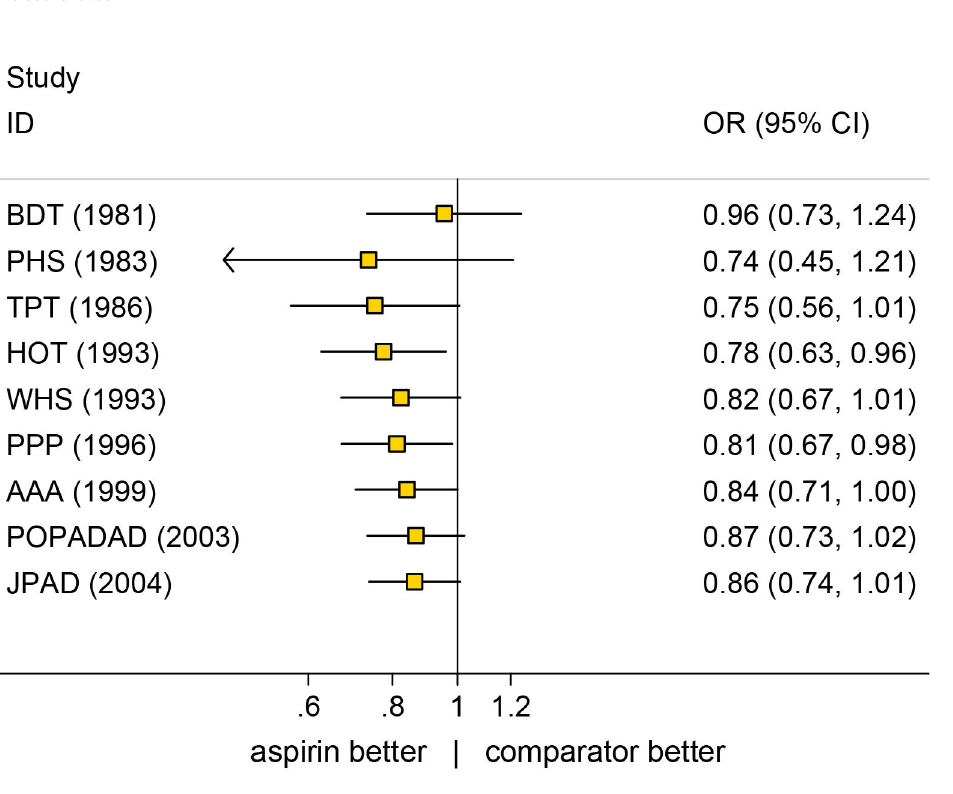
Figure 2. Cumulative random effects meta-analysis of odds ratio for total CHD. Studies arranged according to recruitment year (data from Seshasai et al., 2012)